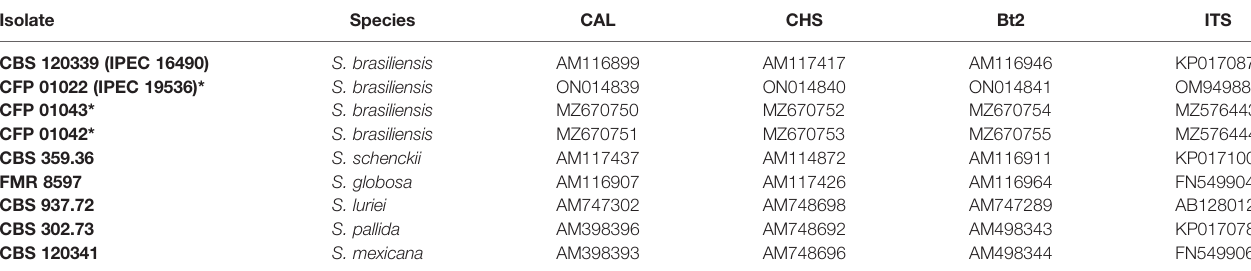
TABLE 1 | Isolates and GenBank Identi fi